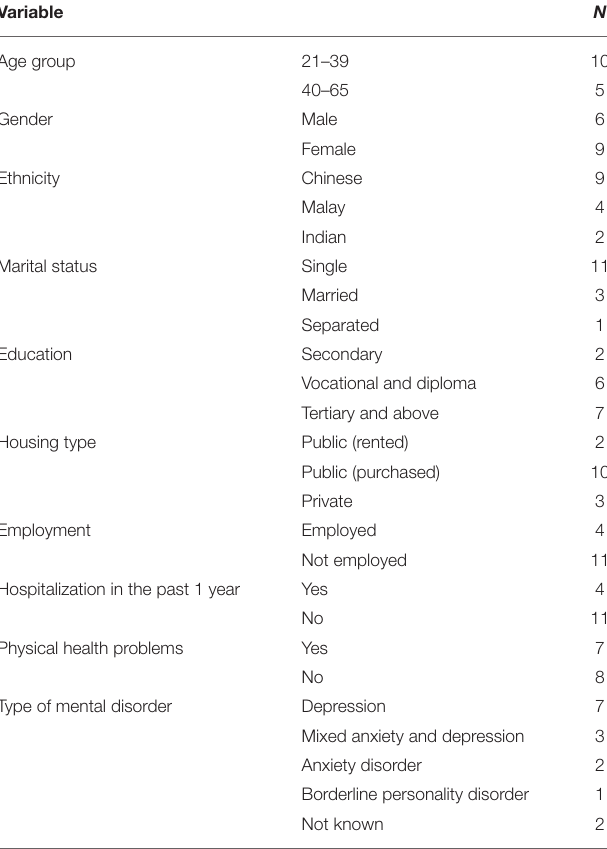
TABLE 2 | Characteristics of